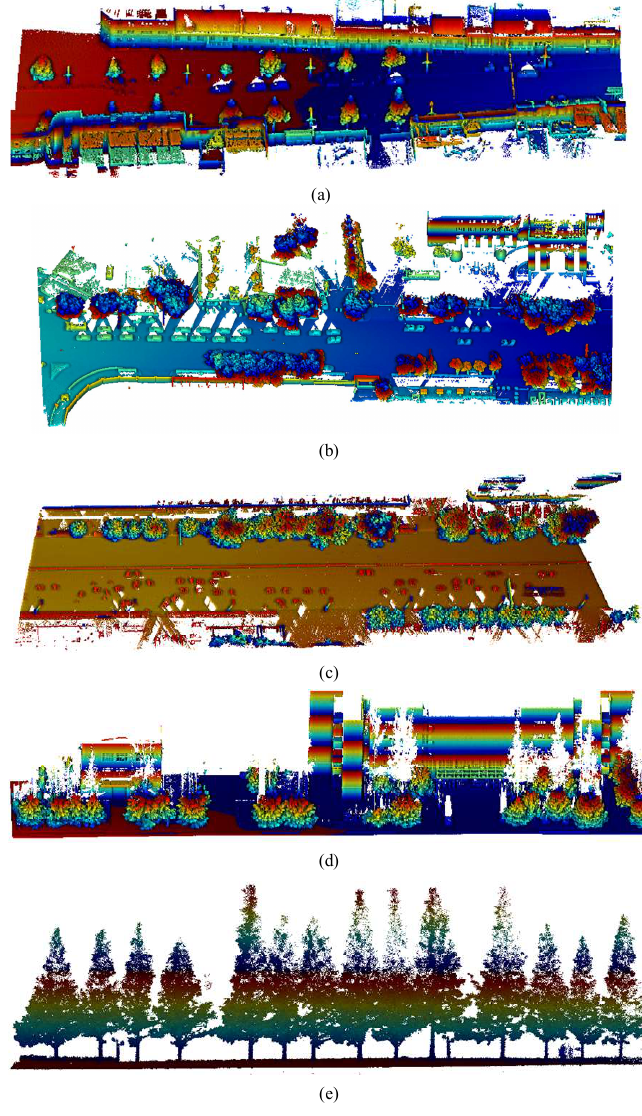
Figure 1. Original point cloud data: ( a ) dataset 1; ( b ) dataset 2; ( c ) dataset 3; ( d ) dataset 4; ( e ) dataset 5.